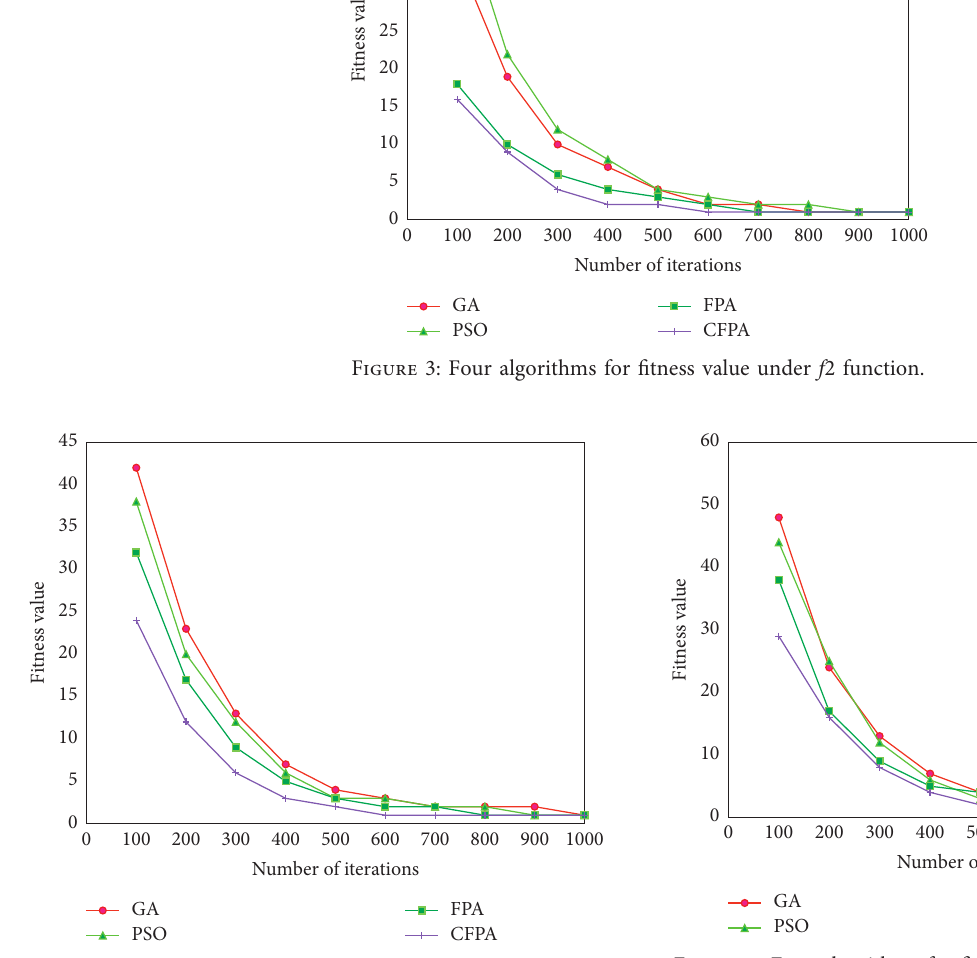
Figure 4: Four algorithms for fitness value under f 3 function. Figure 5: Four algorithms for fitness value under f 4